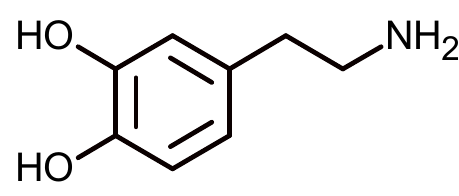
Figure 7. Chemical structure of dopamine.